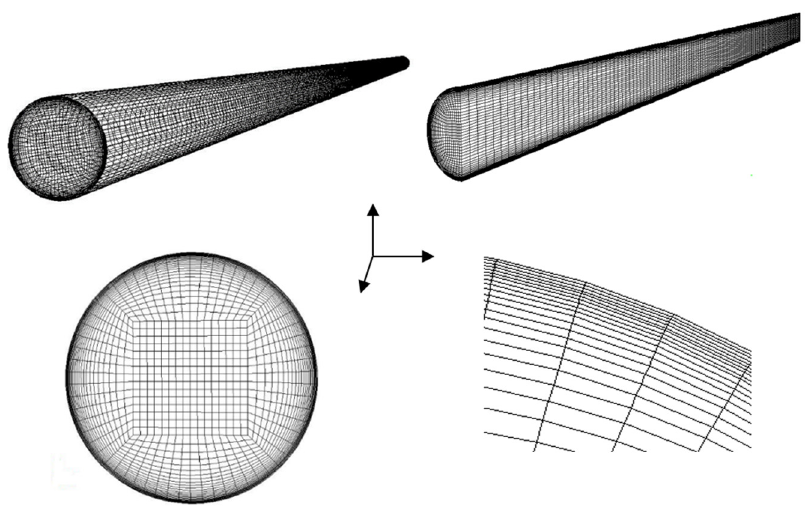
Figure 8. 3D computational meshes of a full and half a pipe ( top ), and cross-section views at a mid-plane and in the near-wall ( bottom ).